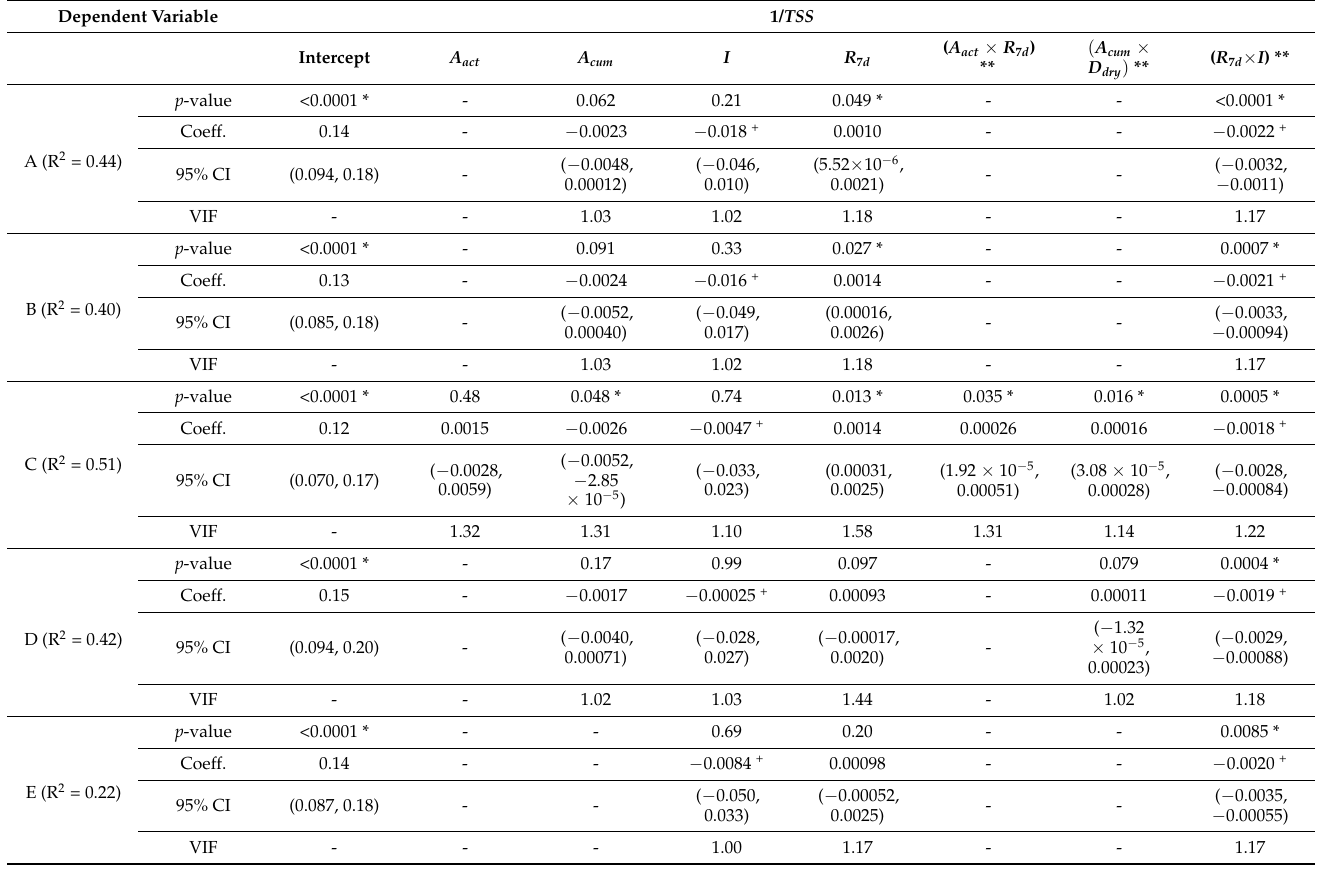
Table 8. Statistical models to predict the concentration of TSS in the five oyster-growing areas.